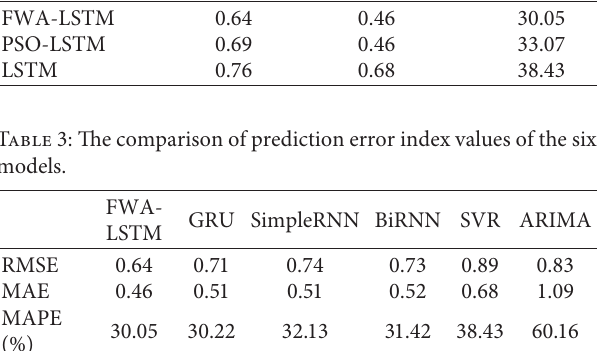
Figure 11: Prediction results of FWA-LSTM and other prediction methods. Table 2: The comparison of prediction error index values of the eight models. Method RMSE MAE MAPE (%)